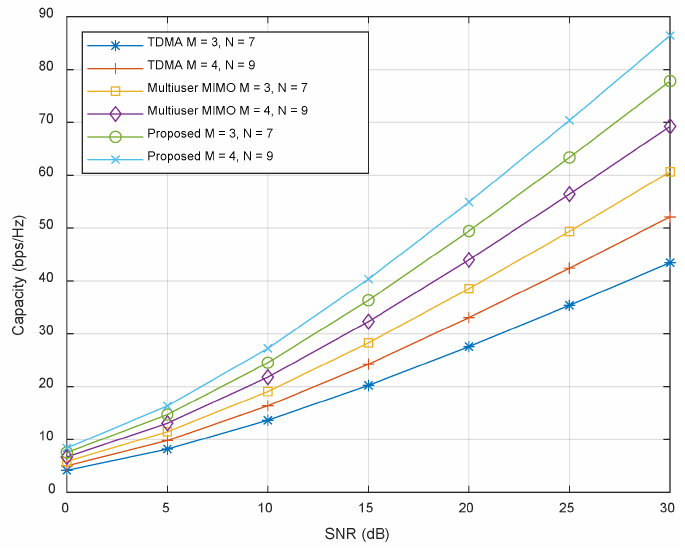
Figure 6. Capacity of different